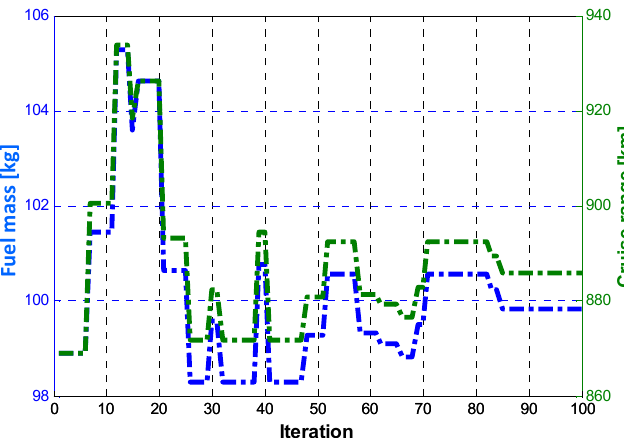
Figure 9. Variation of solutions for the number of modules in optimization Problem 2.